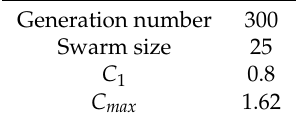
Figure 16. Close-up to the contact area between two bodies analyzed with proposed IGA-BEM before optimization.